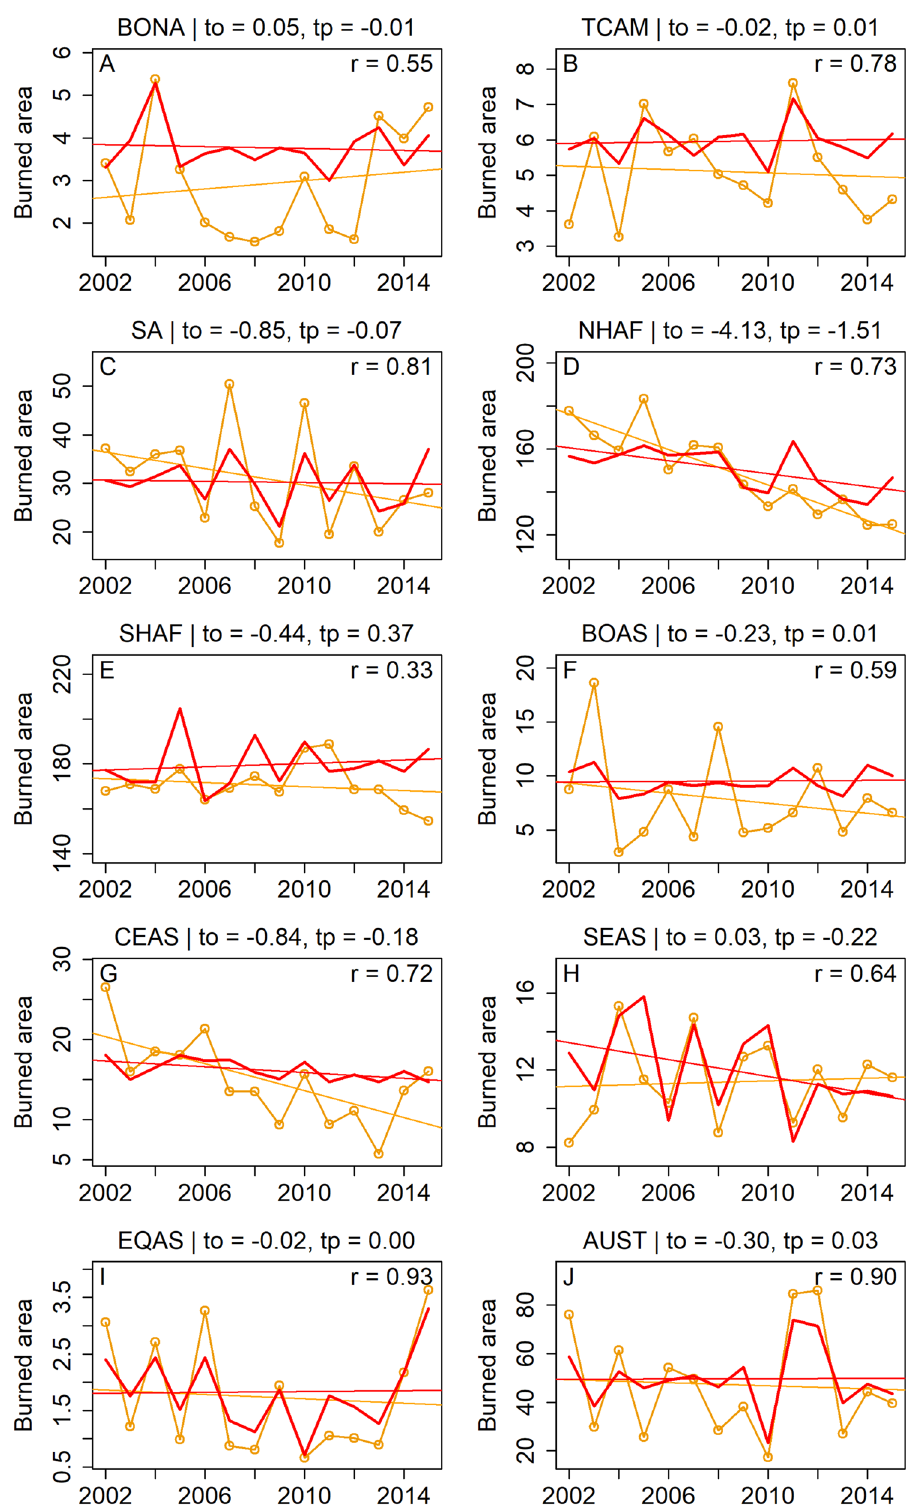
Figure 3. Predicted and observed interannual burned area. Total annual burned area observed in different geographic regions (orange lines and circles) along with that predicted by the minimal model for each region (solid red line). Regression lines indicate the long-term trend in burned area, with the trends in observed ( t o ) and predicted ( t p ) burned areas mentioned above each panel. Interannual variability in burned area is well captured in our model, especially in Equatorial Asia, Australia, Southeast Asia, and South America. Long-term decline is highest in northern Africa, with our model predicting 36% of the observed decline. Fires in southern Africa drop sharply after